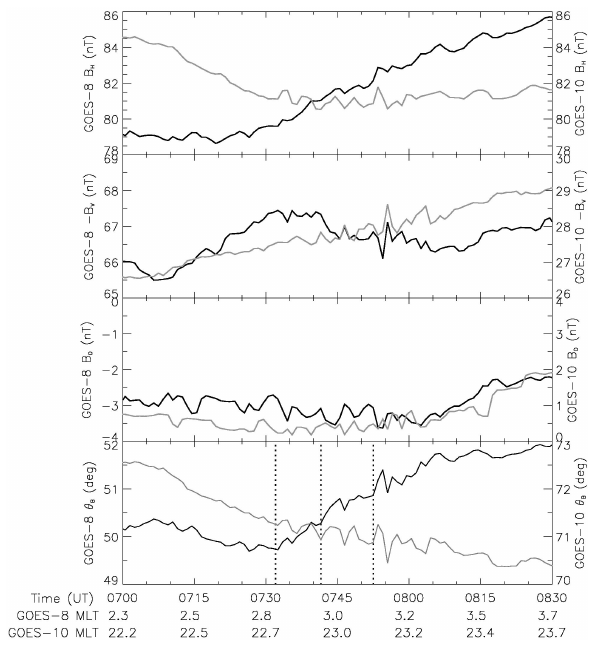
Figure 11 Magnetic fields observed by GOES-8 (black line, left coordinate axis) and GOES-10 (gray line, right coordinate axis). The first, second, and third panels show the B H , - B V , and B D components, respectively. The fourth panel gives the magnetic elevation angle defined by equation 1. The MLT of the ionospheric footprint of the satellites, labeled at the bottom of the plot is calculated from the T89c model (Tsyganenko, 1989) with Kp=1.